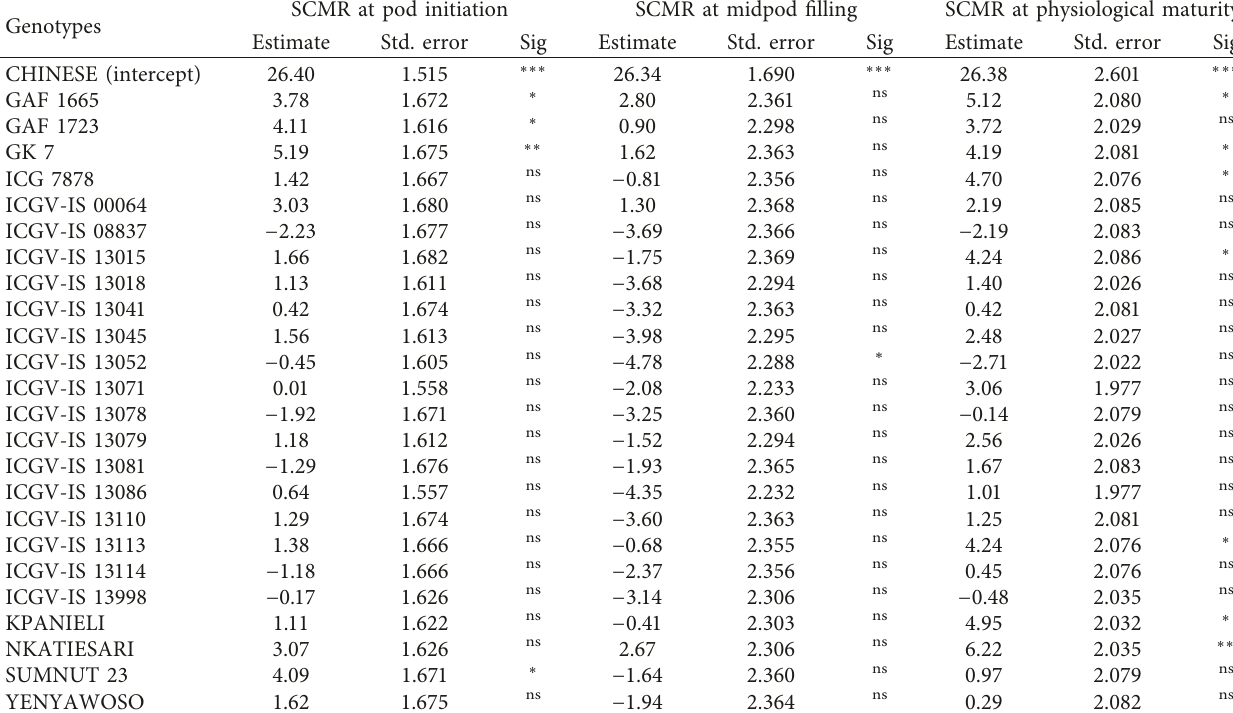
Table 5: Leaf chlorophyll content (SCMR) of 25 groundnut genotypes evaluated under disease